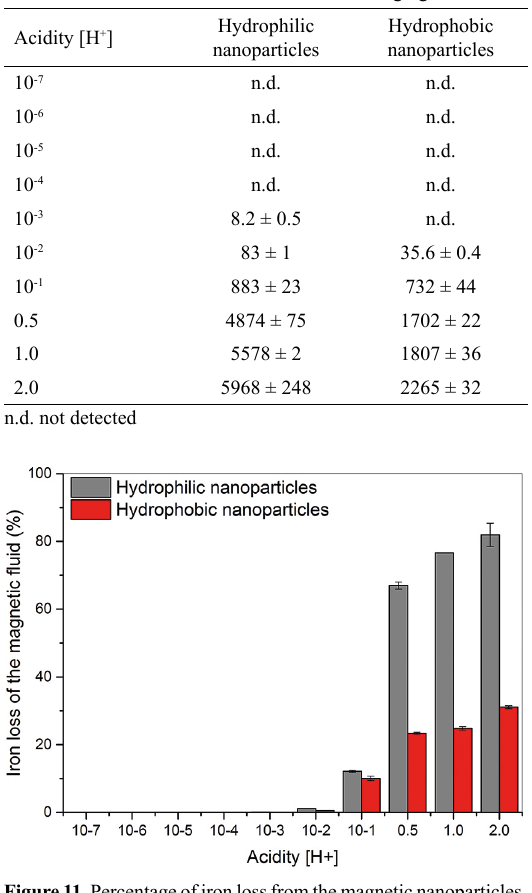
Figure 11. Percentage of iron loss from the magnetic